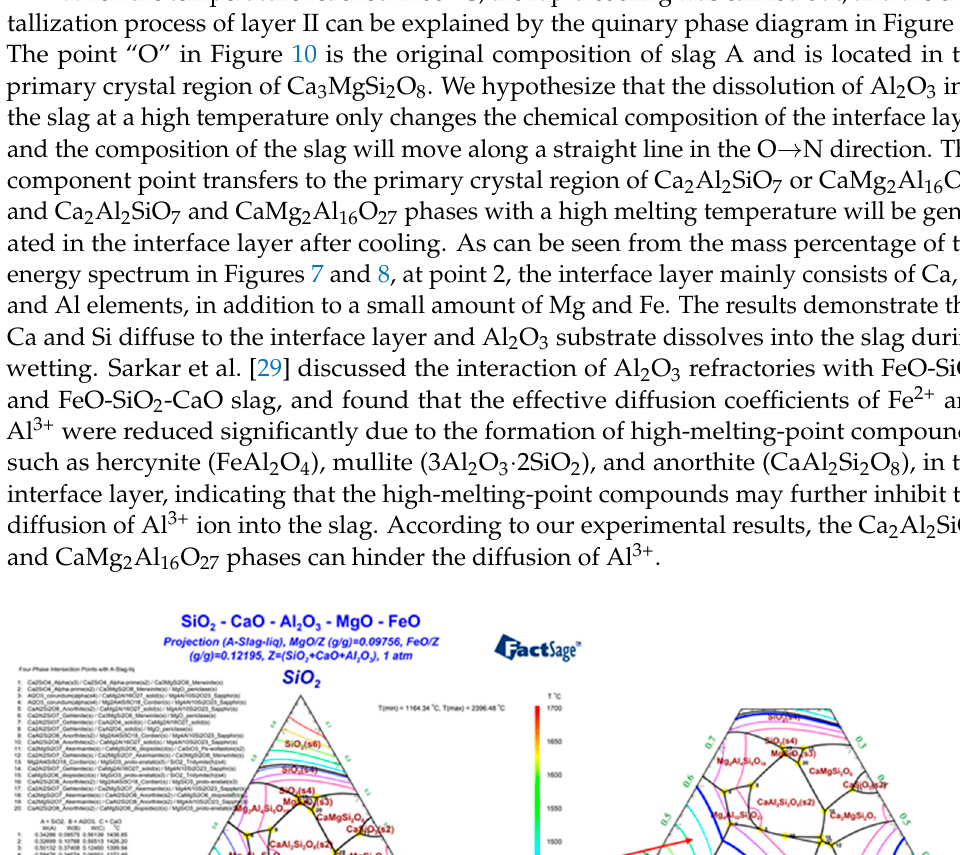
2 O 3 in liquid phase.